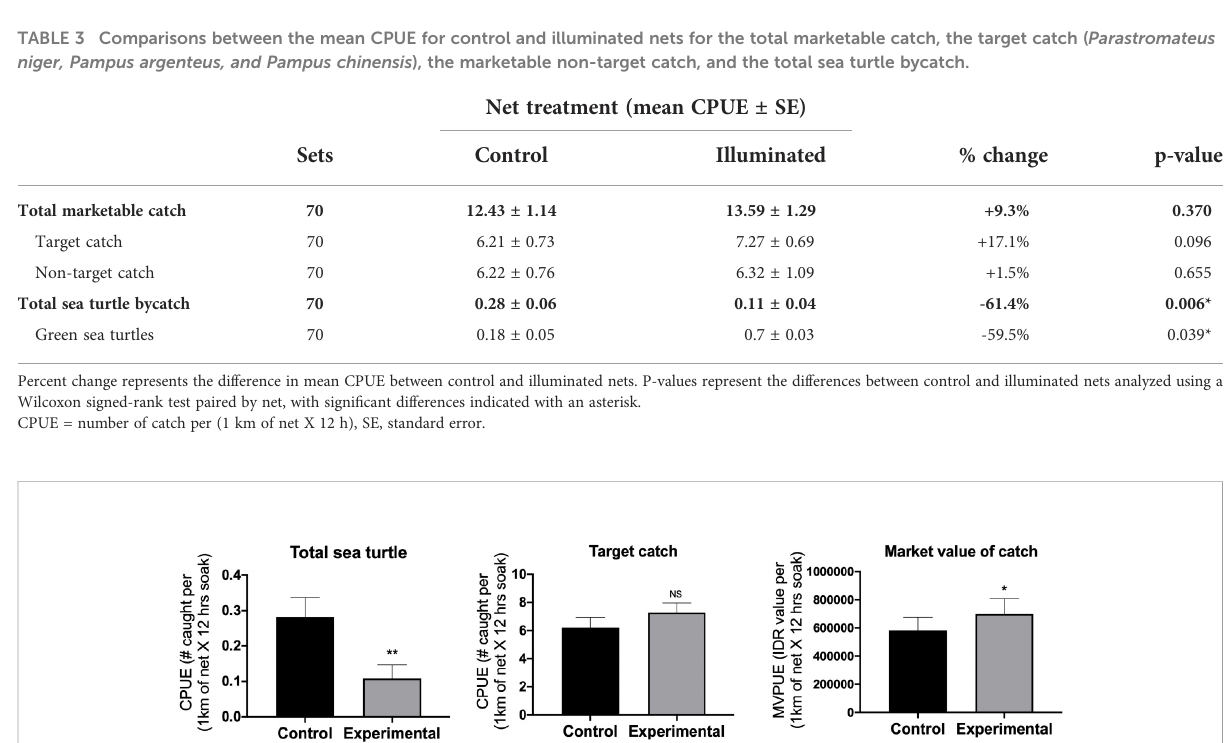
TABLE 3 Comparisons between the mean CPUE for control and illuminated nets for the total marketable catch, the target catch ( Parastromateus niger, Pampus argenteus, and Pampus chinensis ), the marketable non-target catch, and the total sea turtle bycatch.